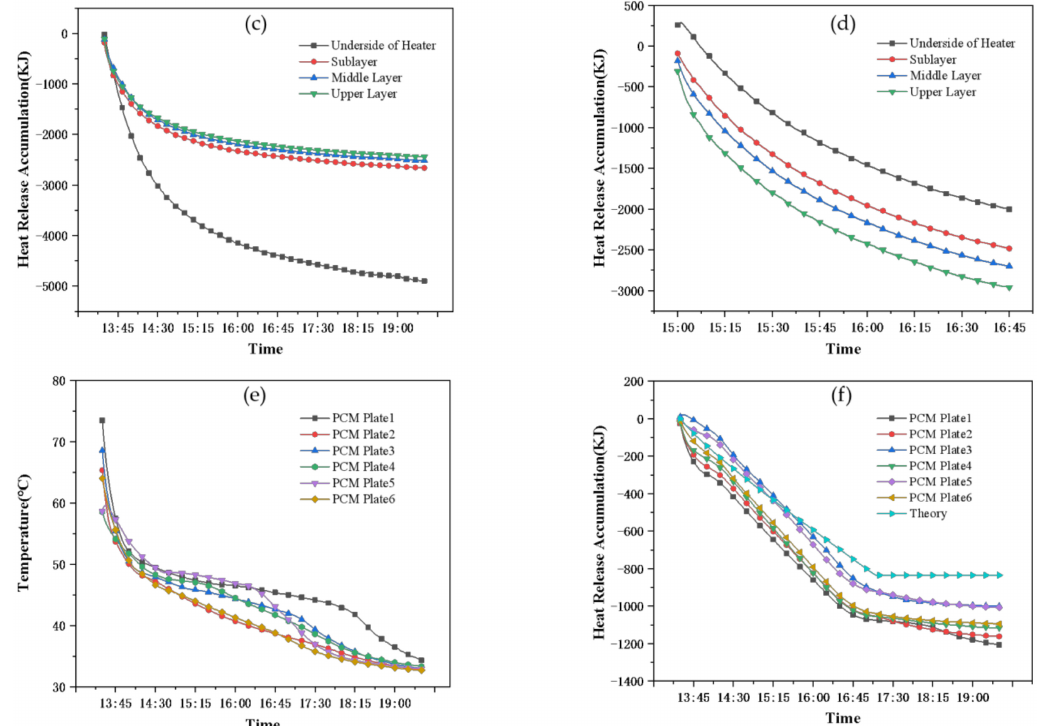
Figure 7. In working condition 2: ( a ) Water temperature curve of the PCM storage tank; ( b ) Water temperature curve of the common tank; ( c ) Heat release accumulation curve of the PCM storage tank; ( d ) Heat release accumulation curve of the common tank; ( e ) Temperature curve of the PCM plate; ( f ) Heat release accumulation curve of the PCM plate.